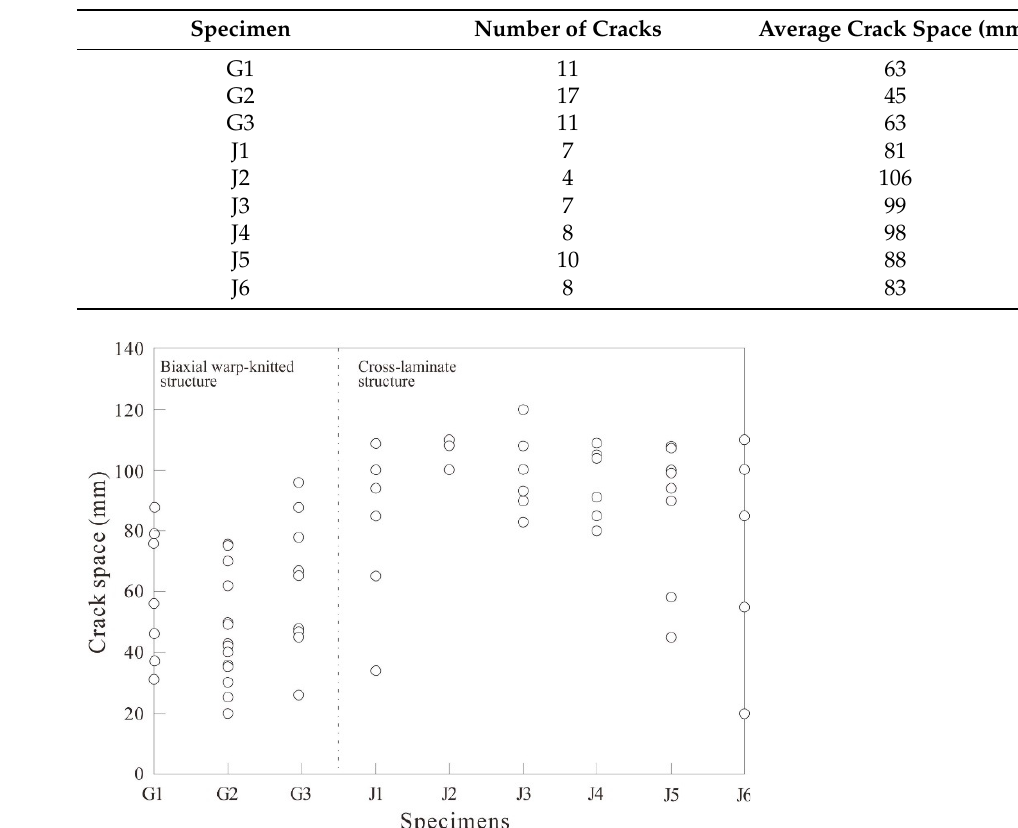
Figure 8. Damage observed in the carbon grids of specimens: ( a ) J5; ( b ) G1; ( c ) G3; and ( d ) G2.